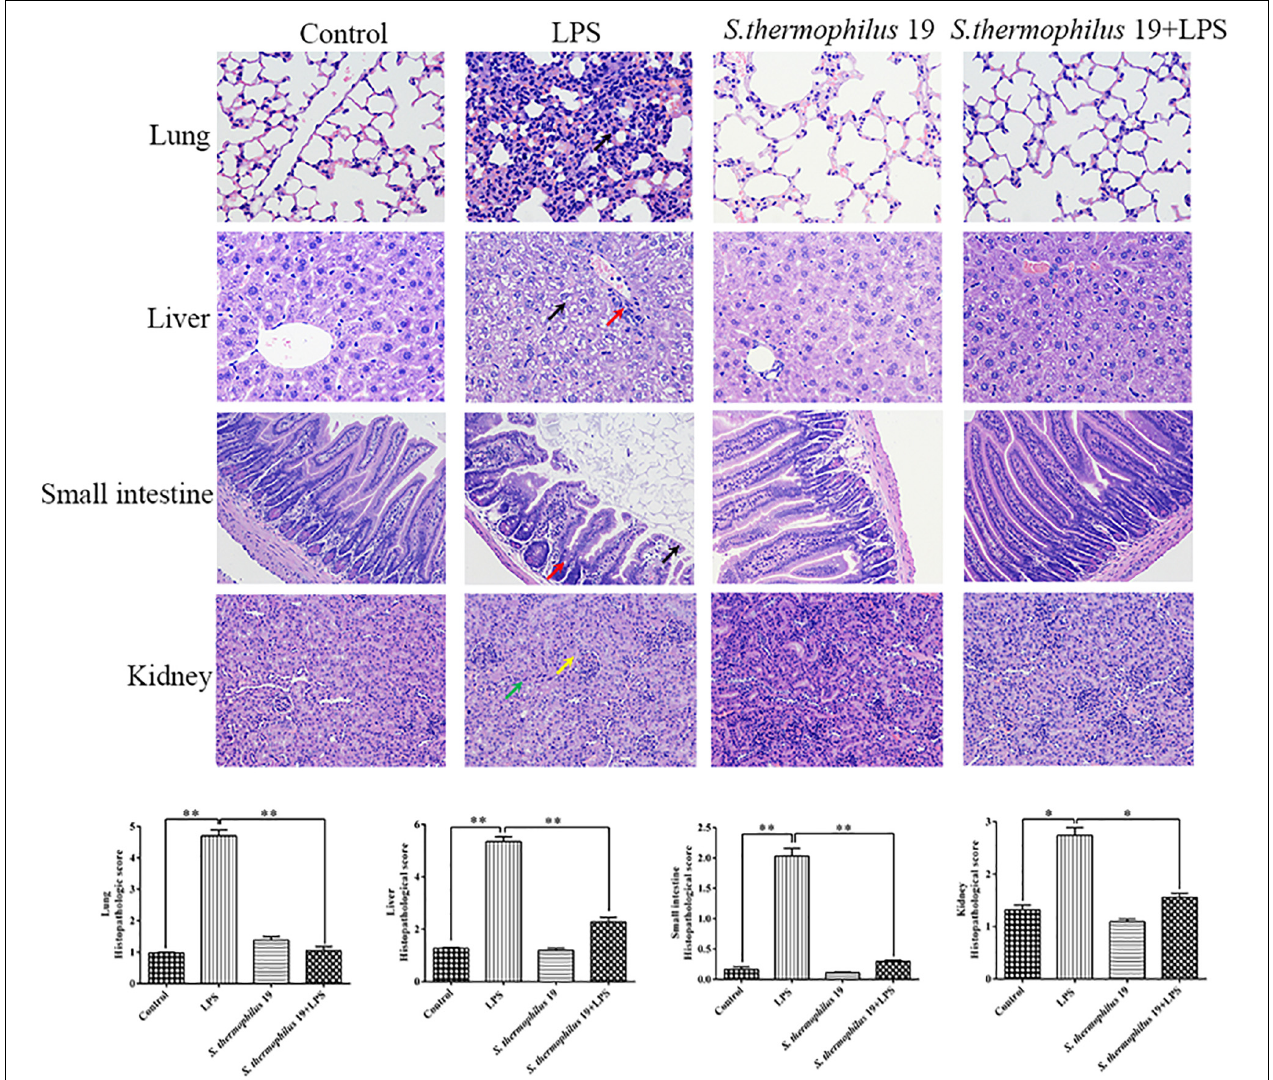
FIGURE 3 | Hematoxylin and eosin staining and histopathologic scores of lung, liver, small intestine, and kidney tissues from different groups. Black arrow in lung sections represent inflammatory cells infiltrating the alveolar walls. In liver sections, black arrow represent that the cytoplasm is loose or vacuolated and red arrow indicates numbers of lymphocytes surrounding the portal area. Black arrow represents epithelial cells exfoliate and red represents inflammatory cells infiltrating in small sections. In kidney sections, yellow arrow represents tubules that are structurally unclear and green arrow indicates a number of tubule epithelial cells swollen and loose. Sections were examined and photographed under a microscope ( n = 8). ∗∗ P < 0.01 and ∗ P <